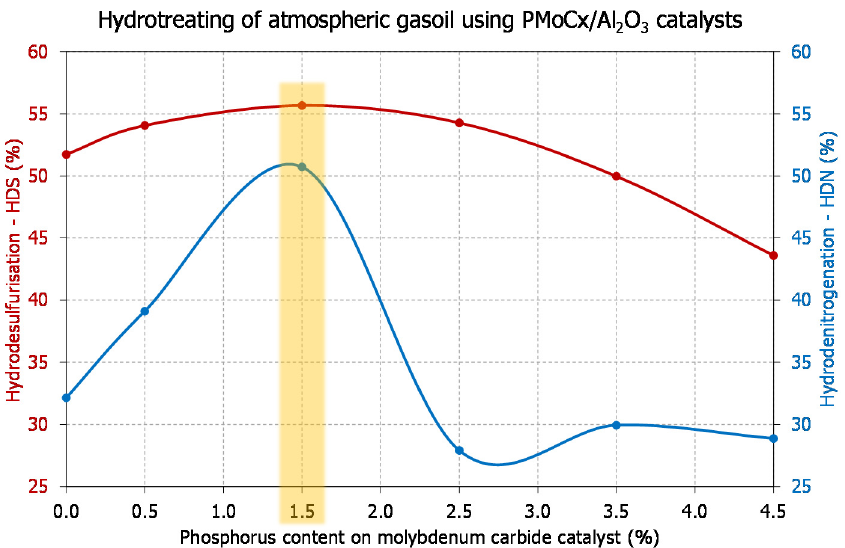
Figure 5. Effect of phosphorus addition on hydrotreating activity of MoCx/Al 2 O 3 catalyst. Red line represents HDS efficiency and it is read at left axis. Blue line represents HDN efficiency and it is read at right axis.